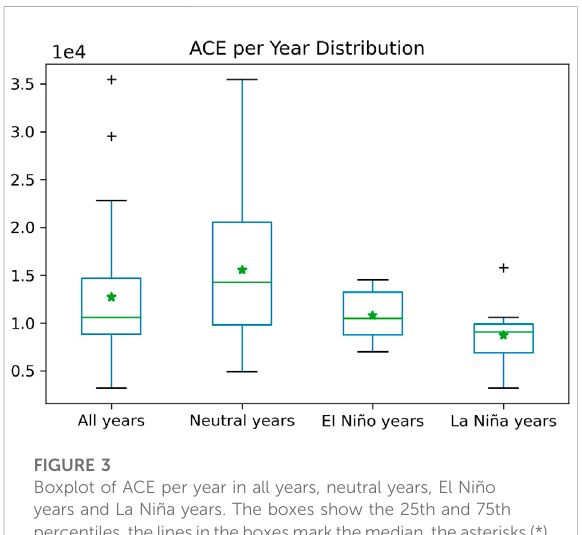
FIGURE 3 Boxplot of ACE per year in all years, neutral years, El Niño years and La Niña years. The boxes show the 25th and 75th percentiles,thelinesintheboxesmarkthemedian,theasterisks(*) mark the mean, and the crosses mark the extreme outliers.